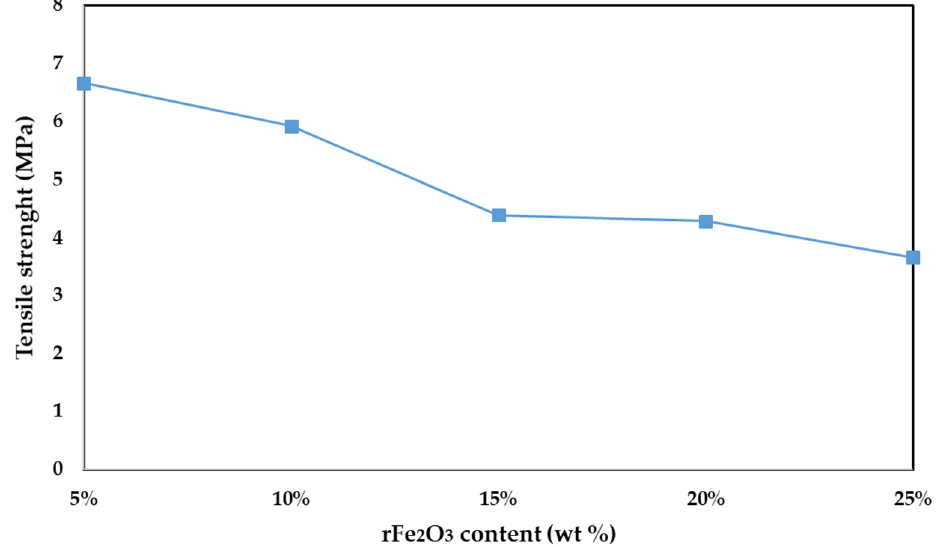
Figure 9. Tensile strength vs. various rFe 2 O 3 nanofiller content for rFe 2 O 3 –PTFE nanocomposites.